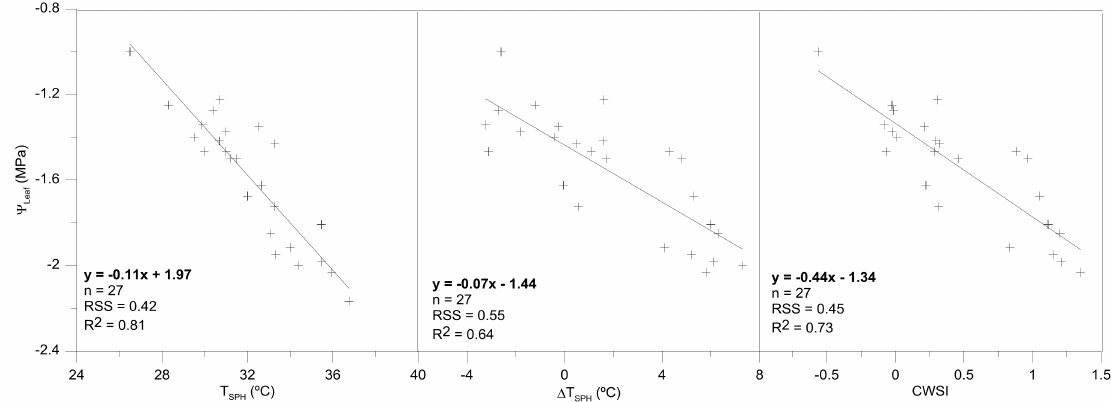
Figure 7. Relationships among different thermal parameters (T SPH ; ∆ T SPH ) taken with Flir One thermal camera connected to smartphone; and the crop water stress index (CWSI)) and the leaf-water potential ( Ψ Leaf ). RSS: Residual Sum of